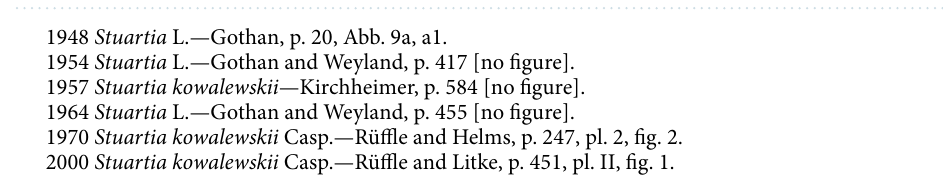
Figure 1. Flower inclusion of Symplocos kowalewskii comb. nov. et emend. (Symplocaceae; X4088) from late Eocene Baltic amber. ( a , b ) Overview of the historic preparation of the amber specimen before restauration, showing fissures ( b , upper arrowhead) and discoloration. The fractured cover slip had been fixed with tape ( b , lower arrowhead). ( c ) Overview of the amber specimen after extraction from the glass chamber. ( d , e ) Flower from the upper ( d ) and lower side ( e ) after preparation. Note the fused staminate ring on the underside ( e , arrowhead). Scale bars 1 cm in ( a ‒ e